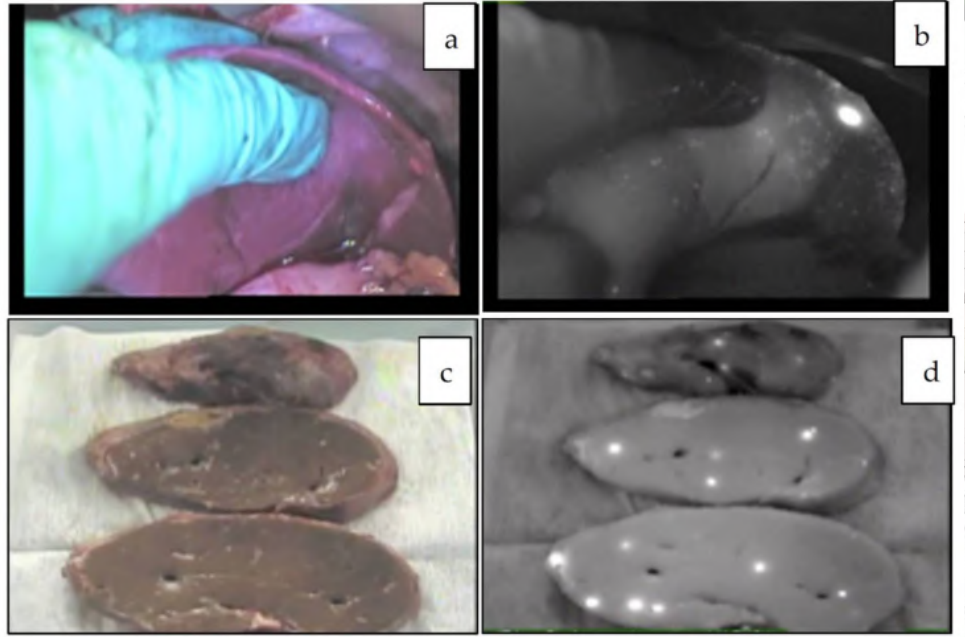
Figure 4. a – d : Multiple metastatic HBs in the transplanted liver in vivo ( a , b ) and ex vivo ( c , d ). This patient underwent the second living donor liver transplantation